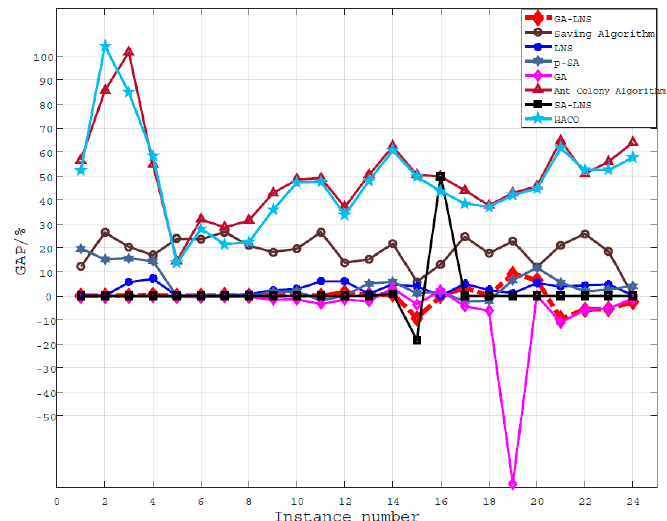
Figure 8. Results of all algorithms compared with the optimal solution.